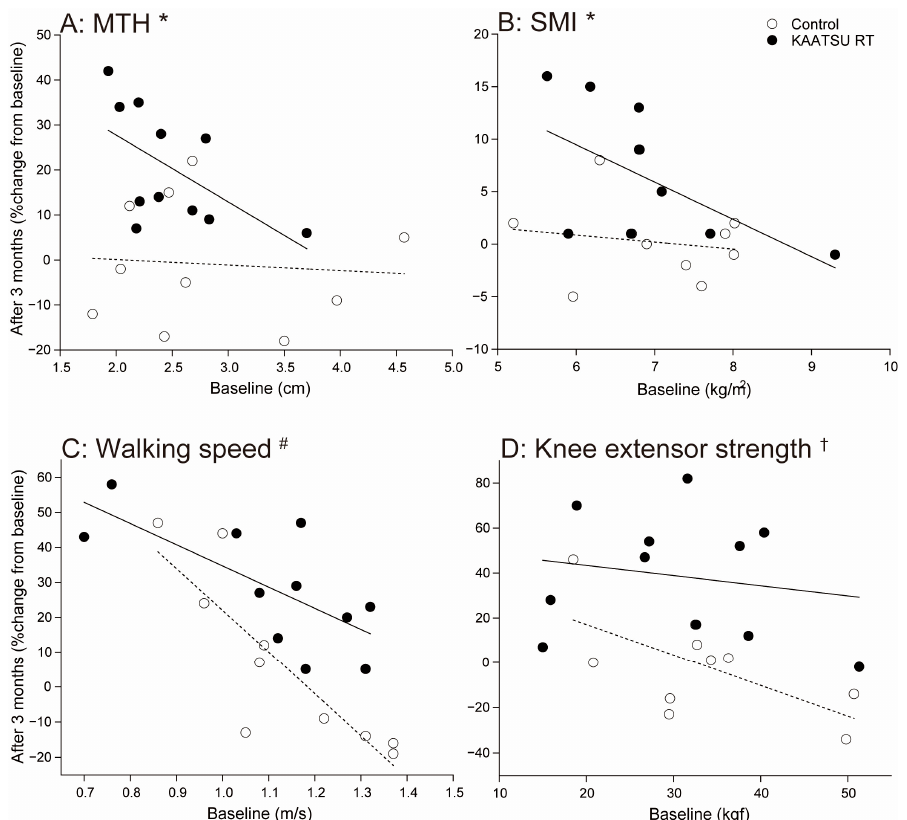
Figure 2. Correlations between baseline and changes after 3 months in MTH, SMI, walking speed, and knee extensor strength. A: correlation for MTH, B: correlation for SMI, C: correlation for walking speed, D: correlation for knee extensor strength. Open circles: the control group, filled circles: the moderate blood flow restriction (KAATSU RT) group. Dotted line: a regression line in the control group, continuous line: a regression line in the KAATSU RT group. *: Significant tendency in the KAATSU RT group ( p < 0.1), # : Significance in the control and the KAATSU RT group ( p < 0.05), † : Significance in the control group ( p <